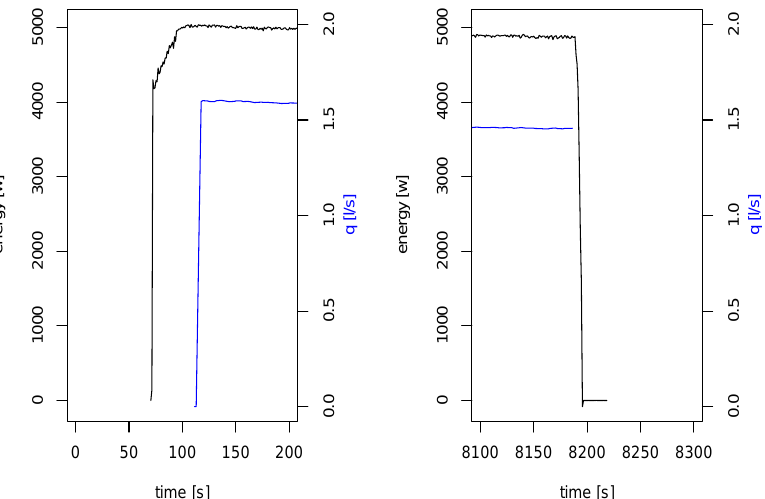
Figure 7. Calibration. Time evolution of water flow and electric power, measured data. Pumping starting ( left ) and ending ( right ).